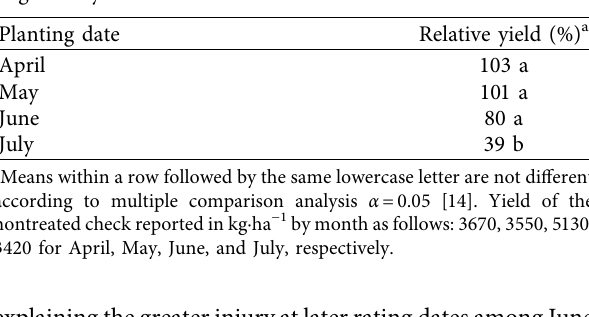
Table 4: Effects of planting date and application timing to maturity date and relative yield for the planting date experiment conducted at Fayetteville and Stuttgart, AR in 2019.